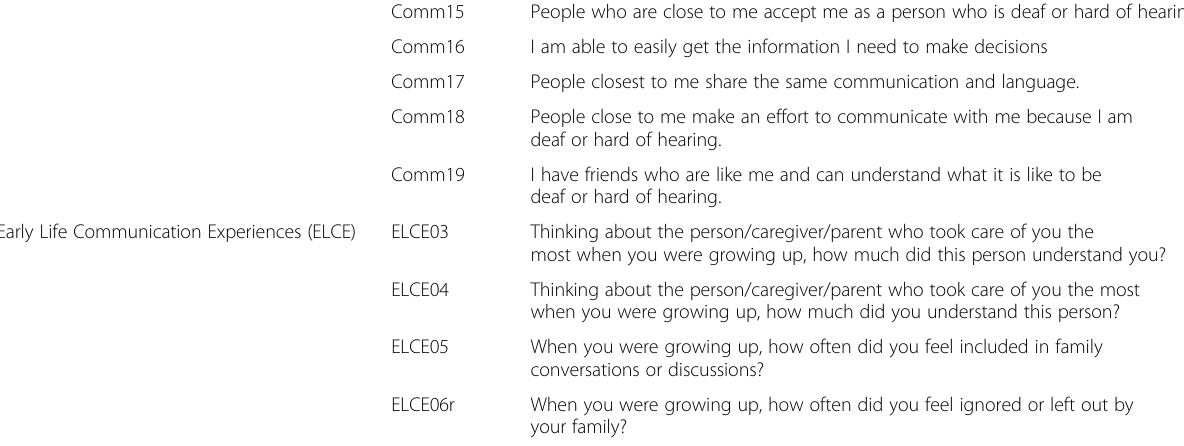
Table 2 Existing and New PROMIS-Deaf Profile Domains and Item Content